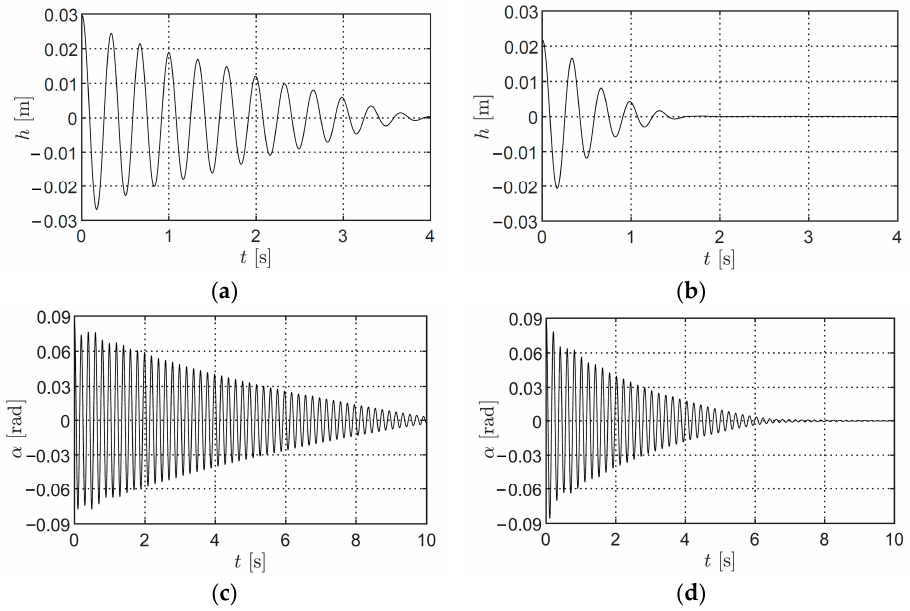
Figure 14. Time history: ( a ) vertical at U = 0 m/s; ( b ) vertical at U = 10 m/s; ( c ) torsional at U = 0 m/s; ( d ) torsional at U = 10 m/s. ( d ) torsional at U = 10